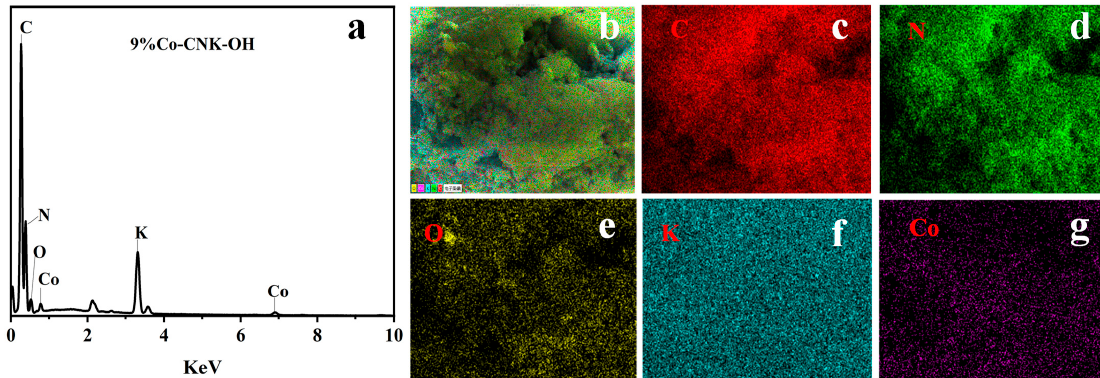
Figure 3. EDS of 9%Co-CNK-OH ( a ) and the elemental mapping images of 9%Co-CNK-OH ( b – g